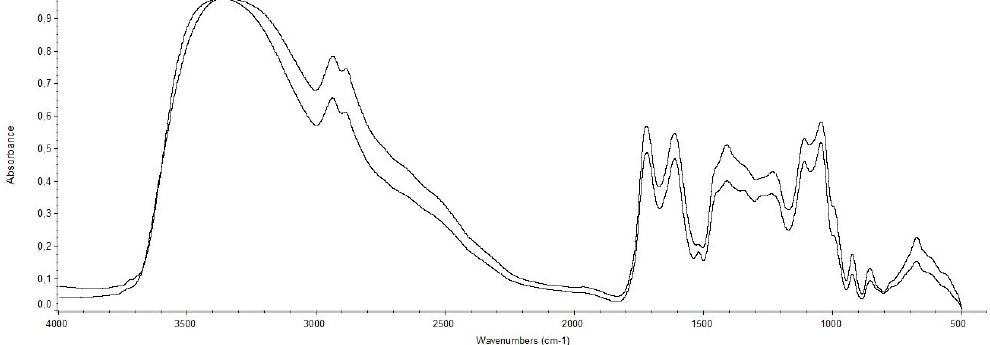
Figure 2. Typical FT-IR spectra obtained from wine samples (red and white wines from Crete, Greece).